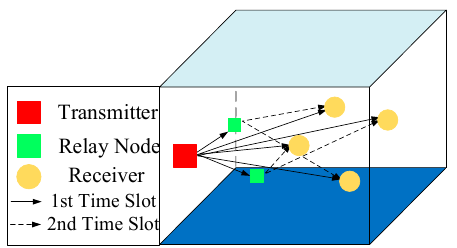
Figure 1. Architecture of the relay-aided NOMA–UOWC system.